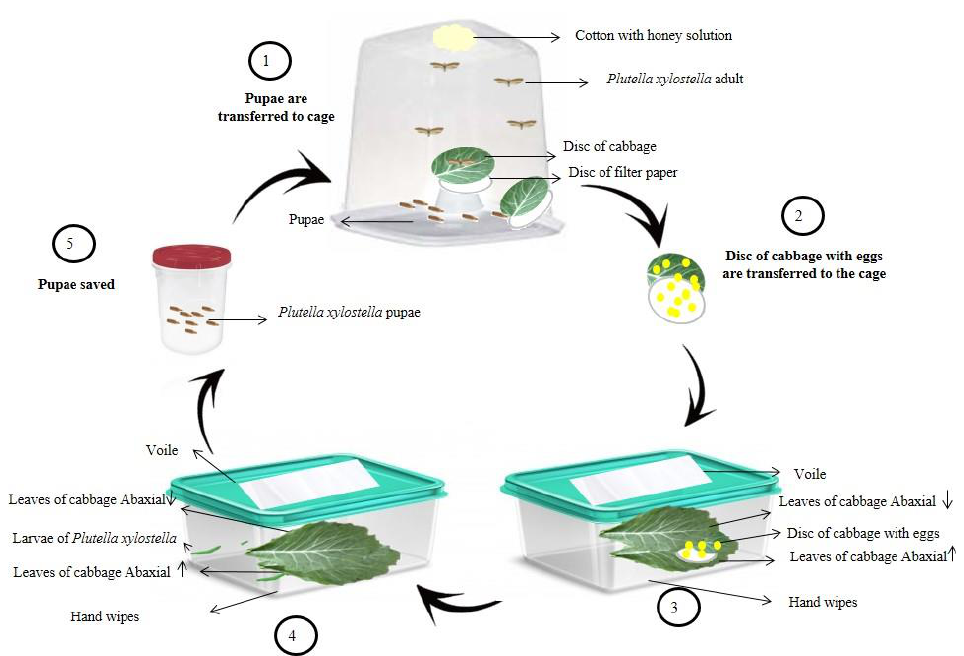
Figure 1. Schematic representation of the methodology adapted for the breeding of Plutella xylostella. Source: Image adapted from Matias da Silva et al. [37].